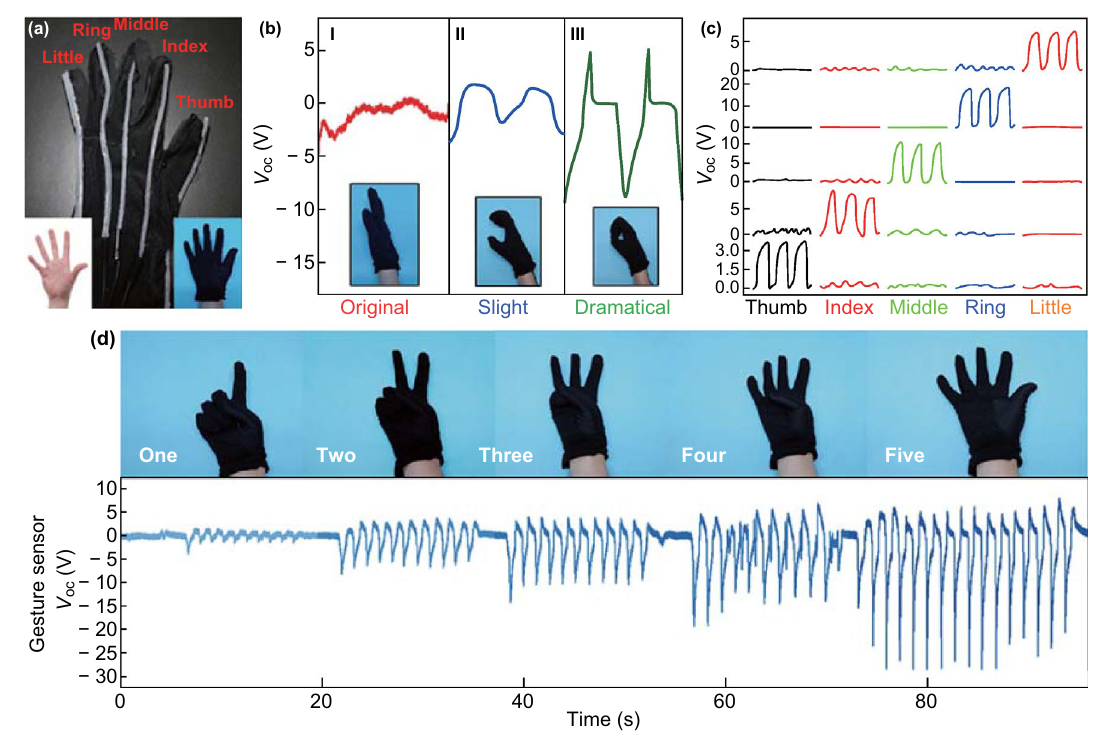
Fig. 5 Demonstration of the FST–TENGs woven in a smart glove as active gesture sensor. a Photograph of the smart glove with FST–TENGs woven on dorsum and demonstration of the operation mode. b Photograph and corresponding V oc of the smart glove under different degree of finger bending, including original state, slightly and dramatically bending. c V oc signals of the five fingers by buckling from the thumb to the little finger in turn. d Demonstrations of the smart glove for representing the numbers of “one”, “two”, “three”, “four” and “five” by different